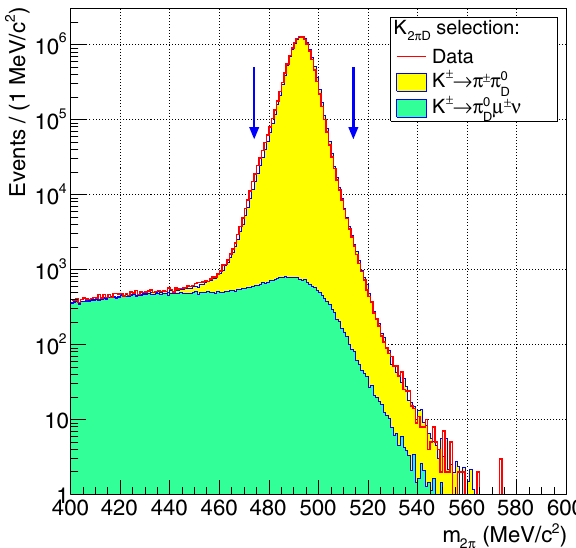
Fig. 37 Invariant mass ( m 2 π ) distribution of data and MC events pass- ing the K 2 π selection. The signal mass region is indicated with vertical arrows